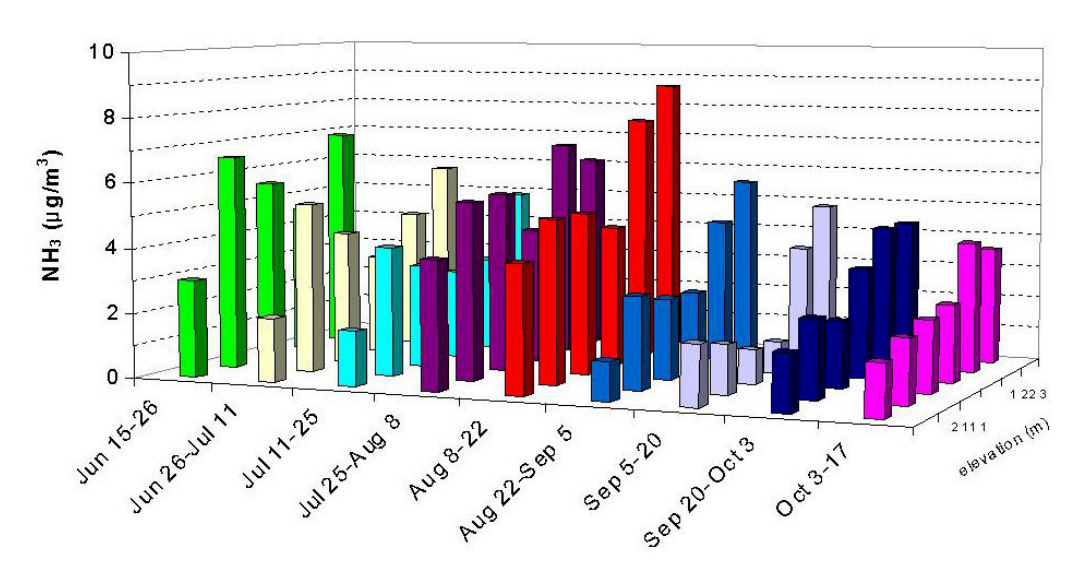
FIGURE 11. Concentrations of NH 3 (µg m -3 ) determined with passive samplers exposed during 2-week long periods during summer